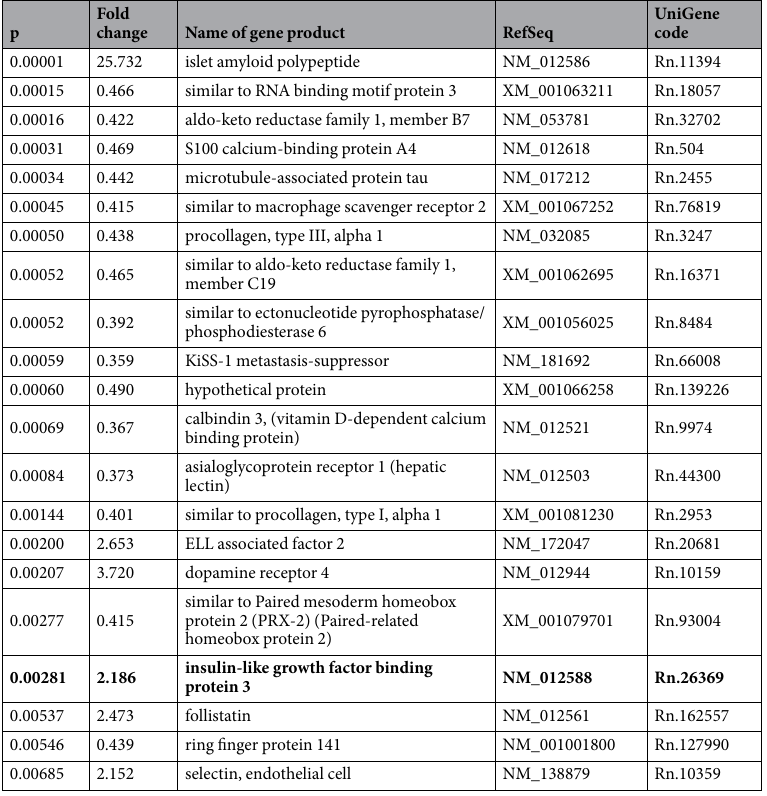
Table 1. Microarray data from lactating mother rats compared to non-maternal previous mothers whose pups were taken away right after delivery (pup-deprived mothers). The listed 21 genes showed highly significant (p < 0.007) difference between the two groups in our microarray study (n = 4 rat for each group) 16